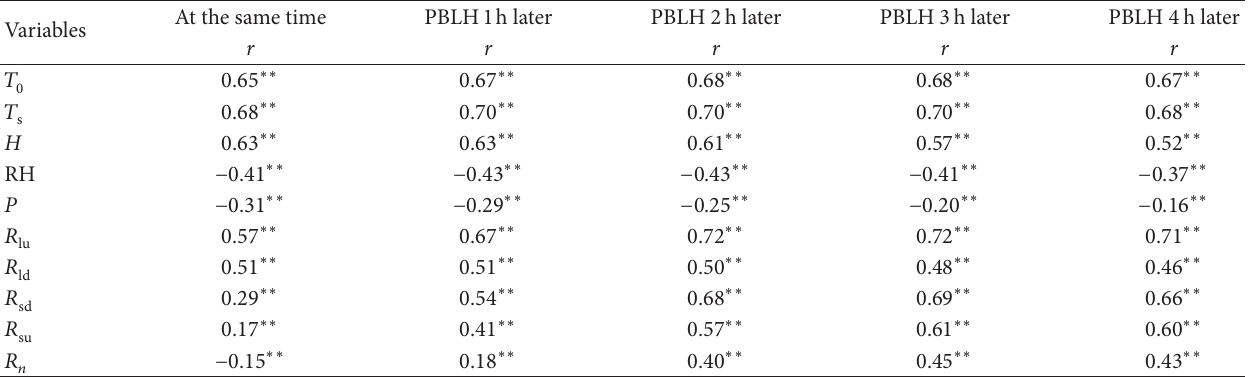
Table 3: Statistical correlations between different atmospheric variables and PBLH with a delay of 1–4 hours ( 𝑇 0 : surface air temperature; 𝑇 s : surface temperature; H: sensible heat flux; RH: surface relative humidity; P : atmospheric pressure; 𝑅 lu , 𝑅 su , 𝑅 ld , and 𝑅 sd : upward long wave and short wave radiation and downward long wave and short wave radiation, respectively; 𝑅 𝑛 : net radiation; r : Pearson correlation coefficient). At the same time Variables